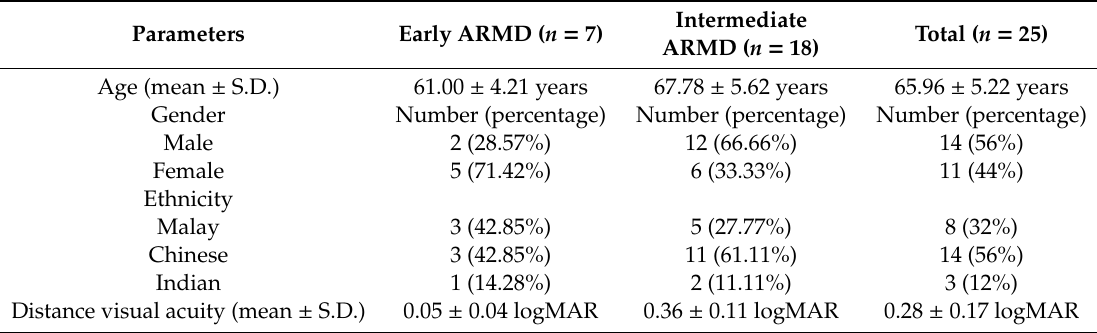
Table 1. Demographic profile of early and intermediate ARMD subjects.